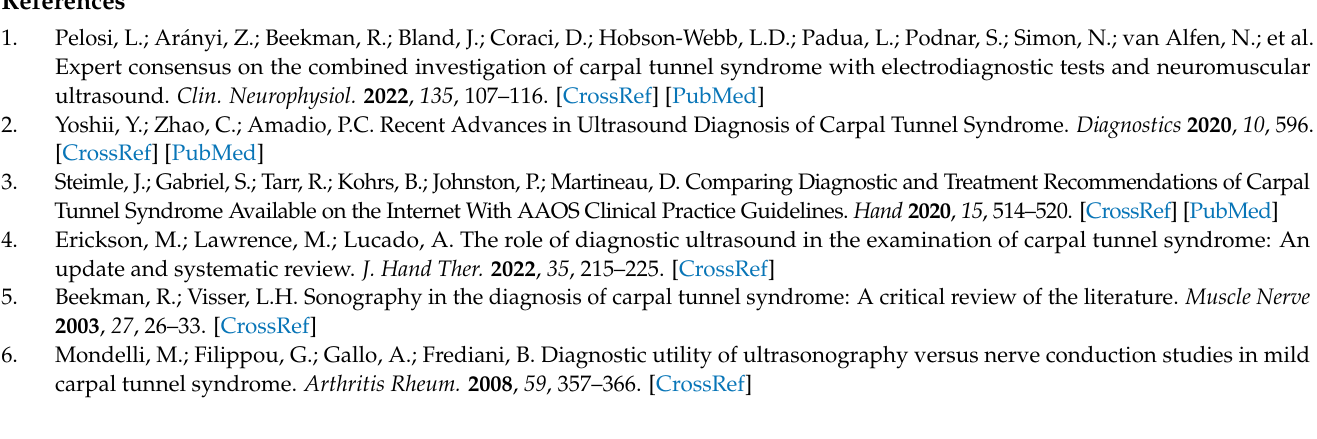
Figure S2: Partial correlation (Spearman); Figure S3: ANOVA (DSCF) MN-CSA and NTR in Padua stages; Figure S4: Binomial regression analysis-ROC